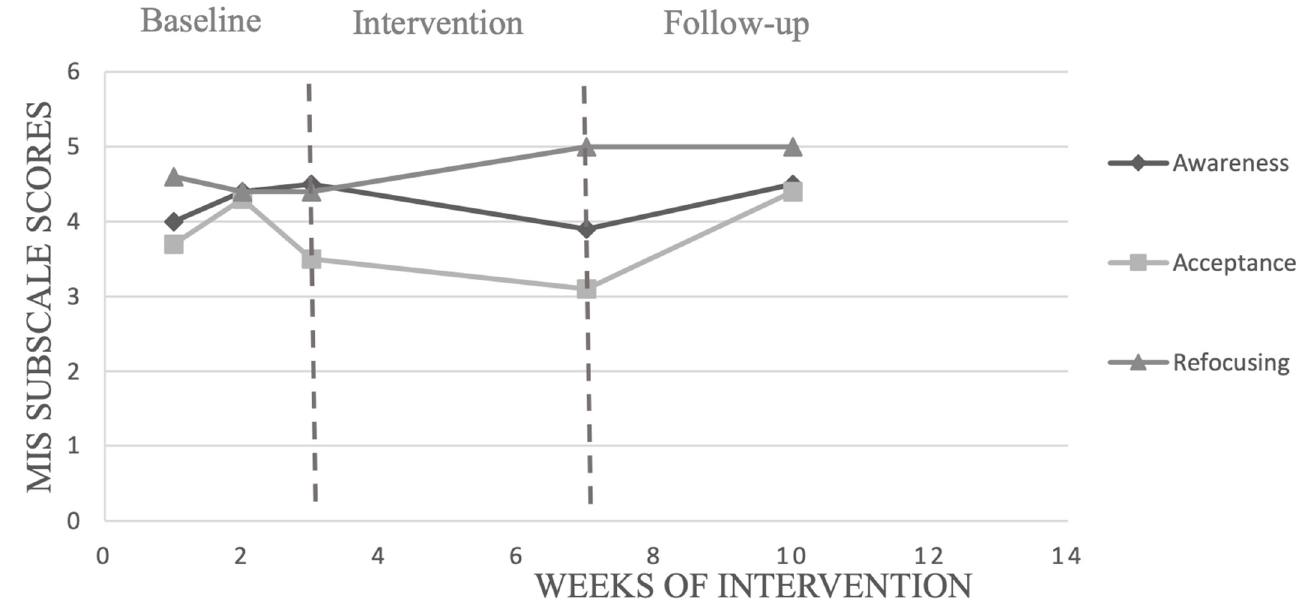
Figure 2. Evolution of scores obtained on the MIS by participant 1, across the weeks of interventions .